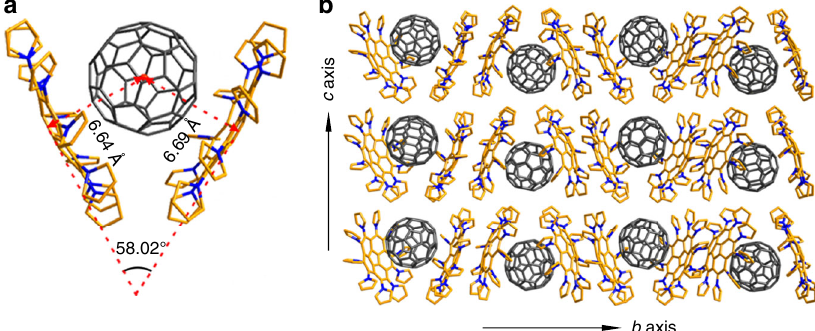
Fig. 3 Crystallographic structure and packing of 2DPC{C 60 }. a Side view of 2DPC{C 60 }. b Packing structure of 2DPC{C 60 } in the b – c plane. C atom in 2a is shown in gold, C 60 in grey and N atom in navy blue. All hydrogen atoms and solvent molecules (CS 2 ) are omitted for